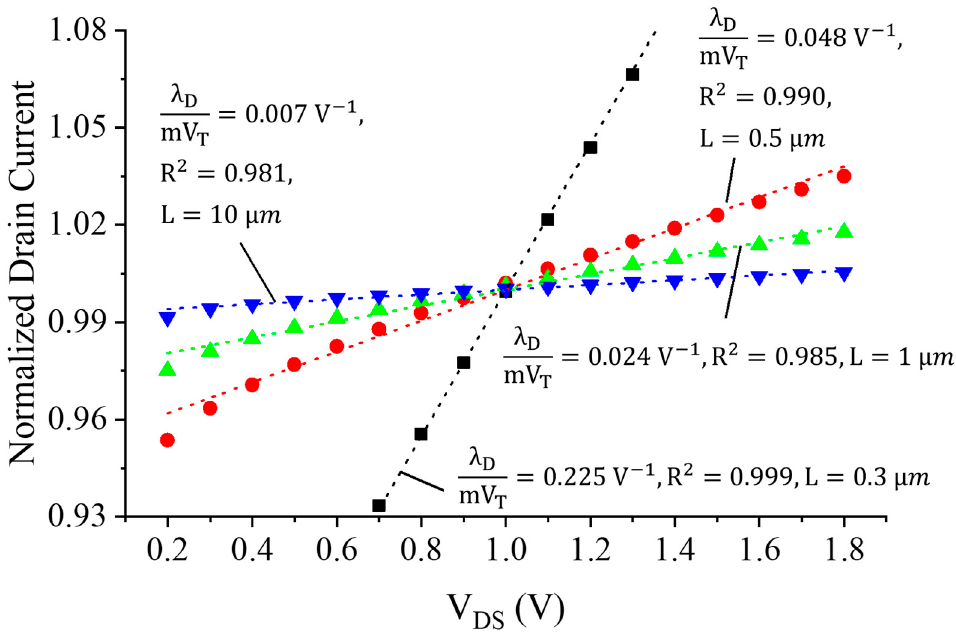
Figure 1. Simulated drain current of different-length PMOS transistors in 180 nm as a function of the drain-source voltage V DS with W / L = 10 and | V GS | = 100 mV for all cases [7].